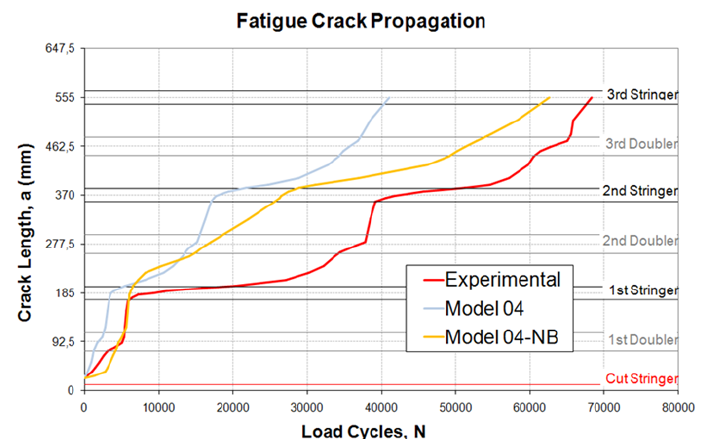
Figure 16: Comparison between experimental and numerical FCP curves (models 4 and